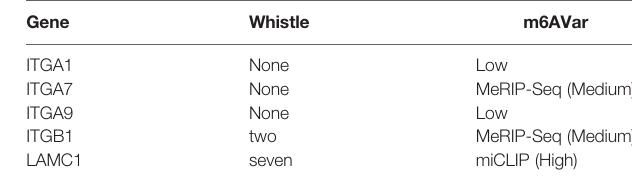
TABLE 3 | m6A methylation sites